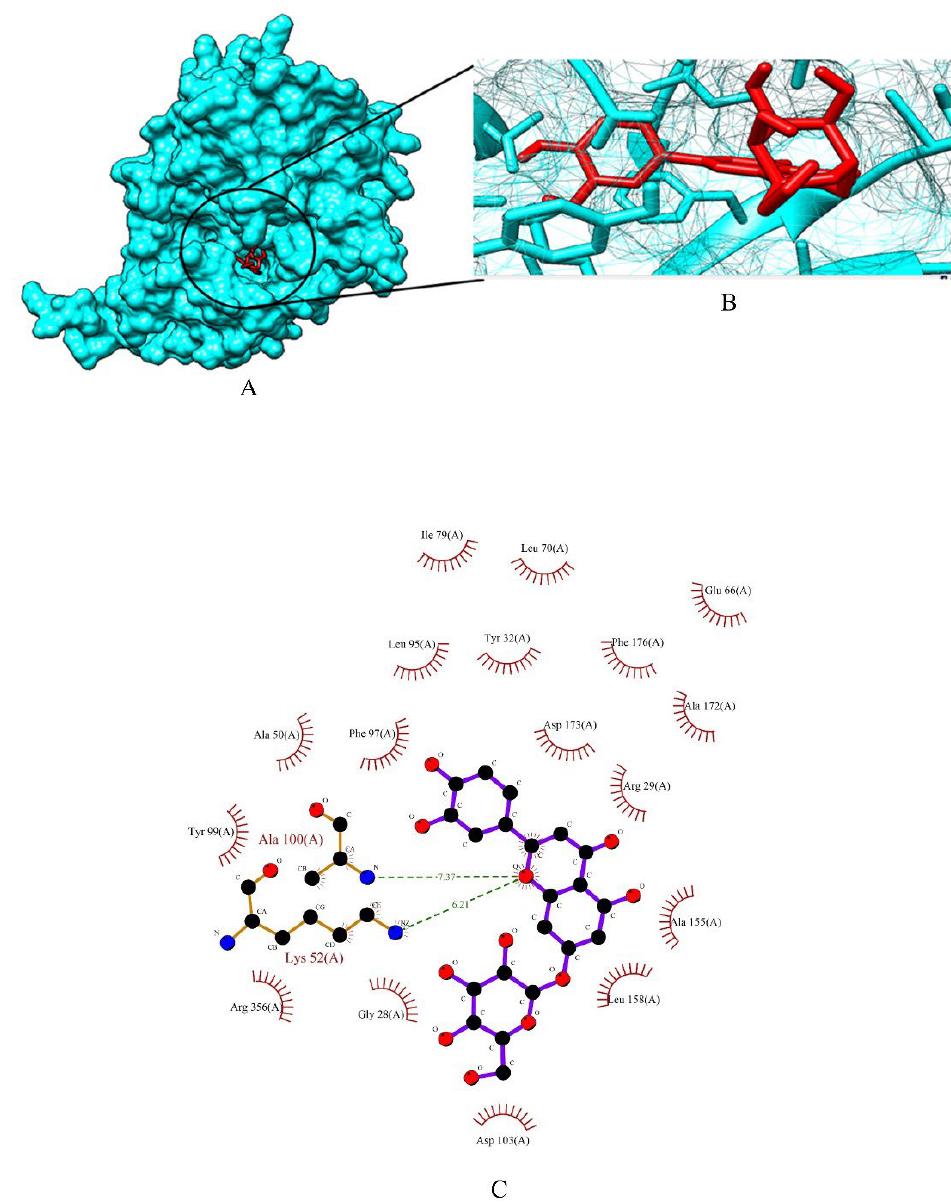
Figure 2. ( A ) Surface view of cynaroside -CDK8 binding complex. ( B ) Binding pose of cynaroside. ( C ) Visualization of the docked complex with ligplot + shows the binding interaction of cynaroside with CDK8. Two hydrogen bond interactions (green dotted lines) were formed between cynaroside and two amino acid residues (Lys 52, Ala 100) of target protein CDK8.